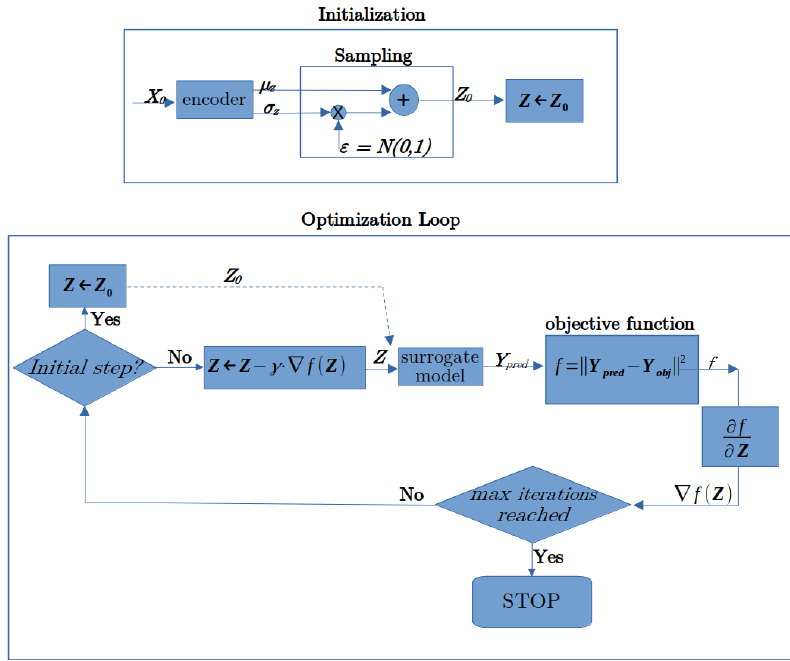
Figure 3. Flux diagram of the optimization